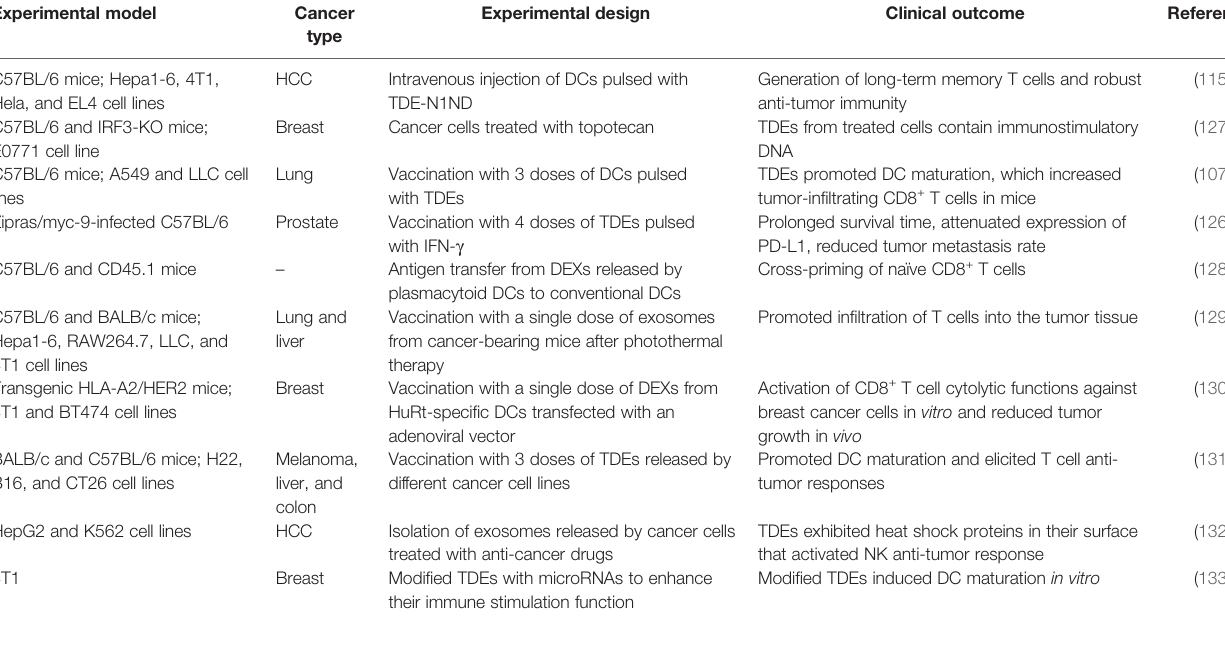
TABLE 1 | Different experimental models and design using exosomes to induce anti-tumor immune responses against several types of cancer. Experimental